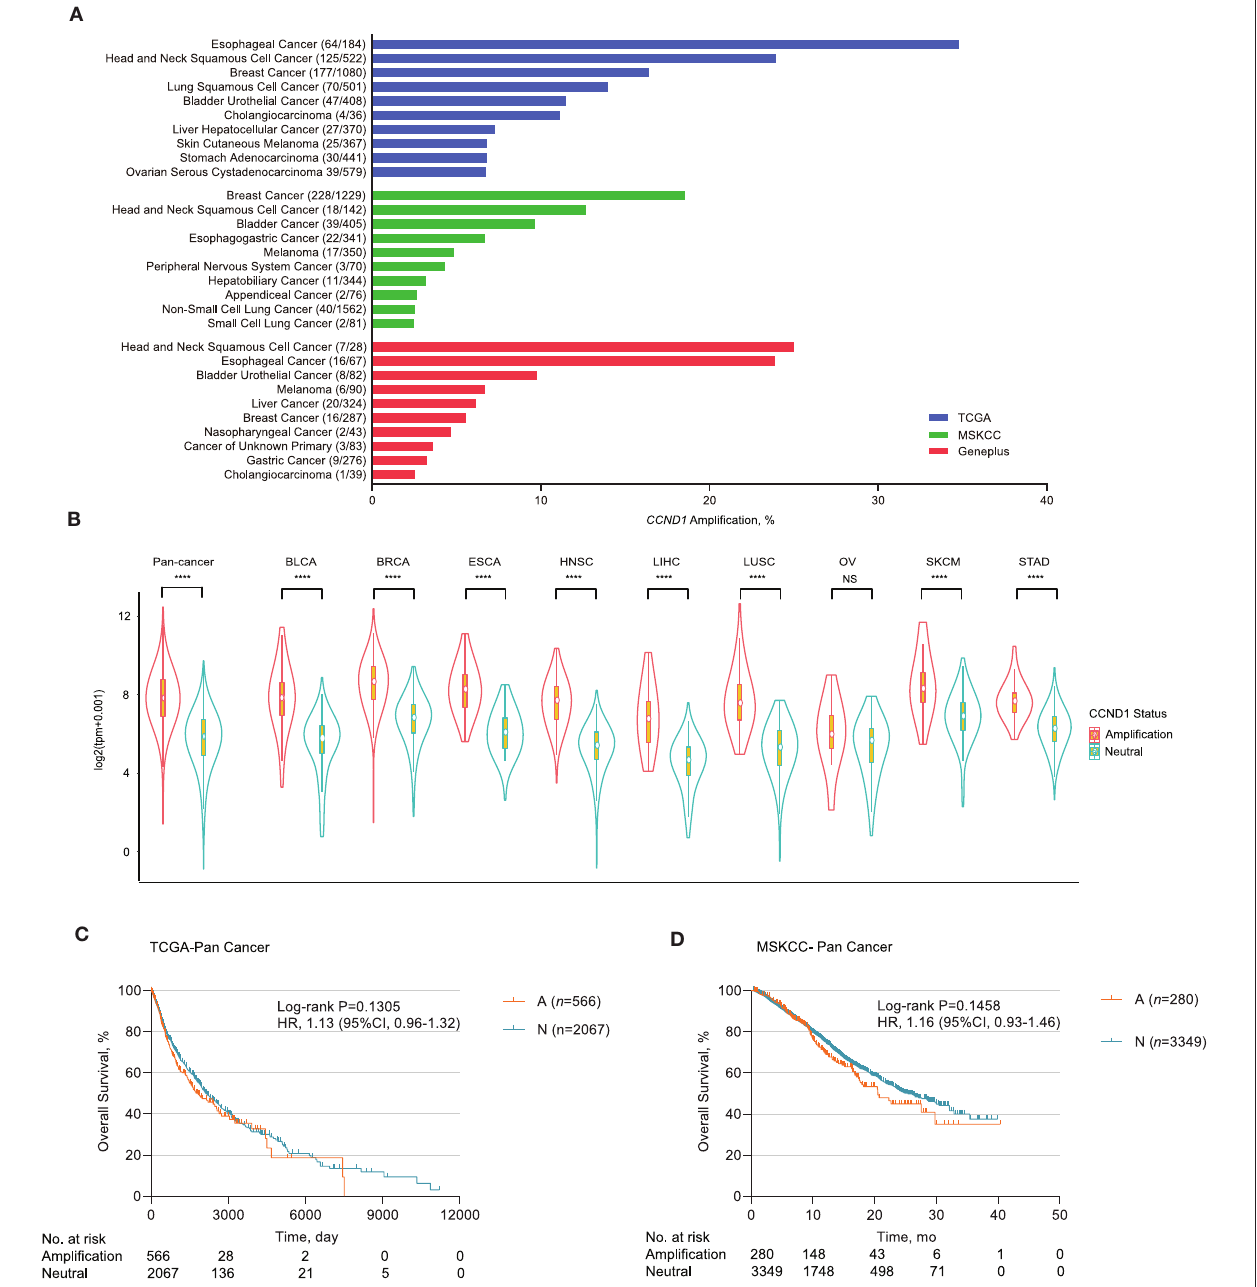
FIGURE 1 | Profile of cyclin D1 (CCND1) amplification and association with prognosis. (A) Distribution of the top 10 cancer types with the frequency of CCND1 amplification in The Cancer Genome Atlas (TCGA) ( n = 10,606), Memorial Sloan Kettering Cancer Center (MSKCC) ( n = 10,109), and Geneplus ( n = 6,536) databases. Cancers were sorted according to the frequency of CCND1 amplification. (B) The gene expression profile of CCND1 between the amplification group and the neutral group in the TCGA pan-cancer cohort ( n = 2,633). The white dot represents the median value. The bottom and top of the violins are the 25th and 75th percentiles (interquartile range). Differences between the two groups were evaluated by unpaired t -tests. ns P ≥ 0.05; * P < 0.05; ** P < 1 × 10 − 2 ; *** P < 1 × 10 − 3 ; **** P < 1 × 10 − 4 . (C) Kaplan–Meier survival analysis of overall survival (OS) comparing the CCND1 amplification and neutral groups in patients in the TCGA pan-cancer cohort ( n = 2,633). (D) Kaplan–Meier survival analysis of OS comparing the CCND1 amplification and neutral groups in patients in the MSKCC pan-cancer cohort ( n = 3,629).